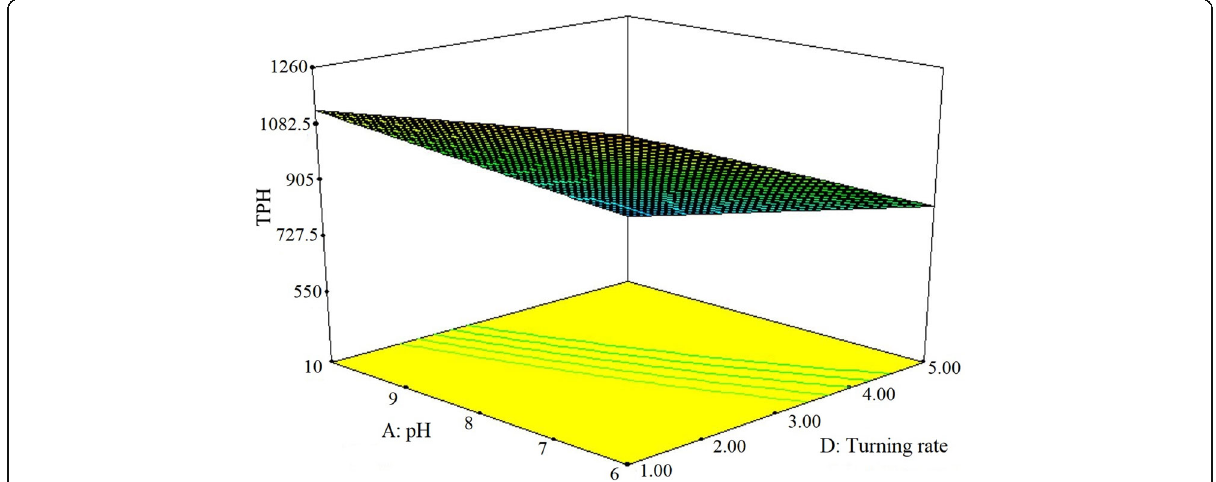
Fig. 7 Effect of pH and turning rate on